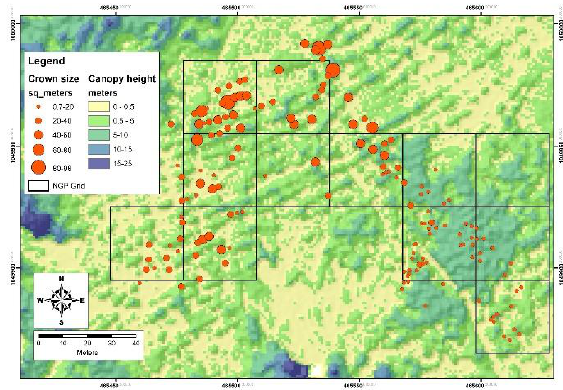
Figure 3. Crown area of 157 Acacia mangium trees